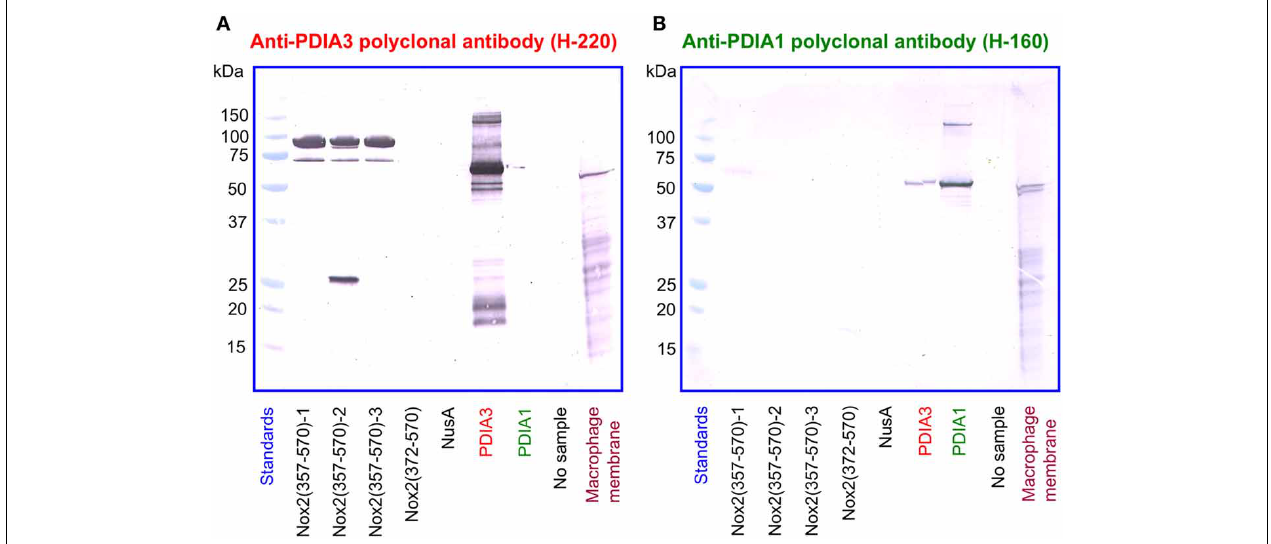
FIGURE 10 | A polyclonal anti-PDIA3 antibody but not a polyclonal anti-PDIA1 antibody reacts with Nox2 by immunoblotting. (A) Polyclonal anti-PDIA3 antibody H-220 reacts with recombinant NusA-Nox2(357–570) but not with NusA-Nox2(372–570) and NusA. It reacts strongly with recombinant PDIA3 but not with recombinant PDIA1. It also recognizes a protein in the guinea pig macrophage membrane